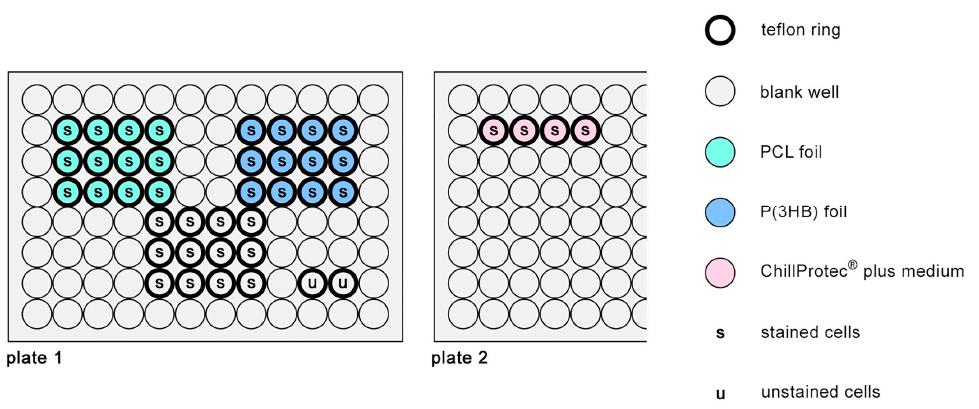
Figure 3. Experimental set-up for vitality and proliferation assays on PCL and poly(3-hydroxybutyrate) (P(3HB)) foils.